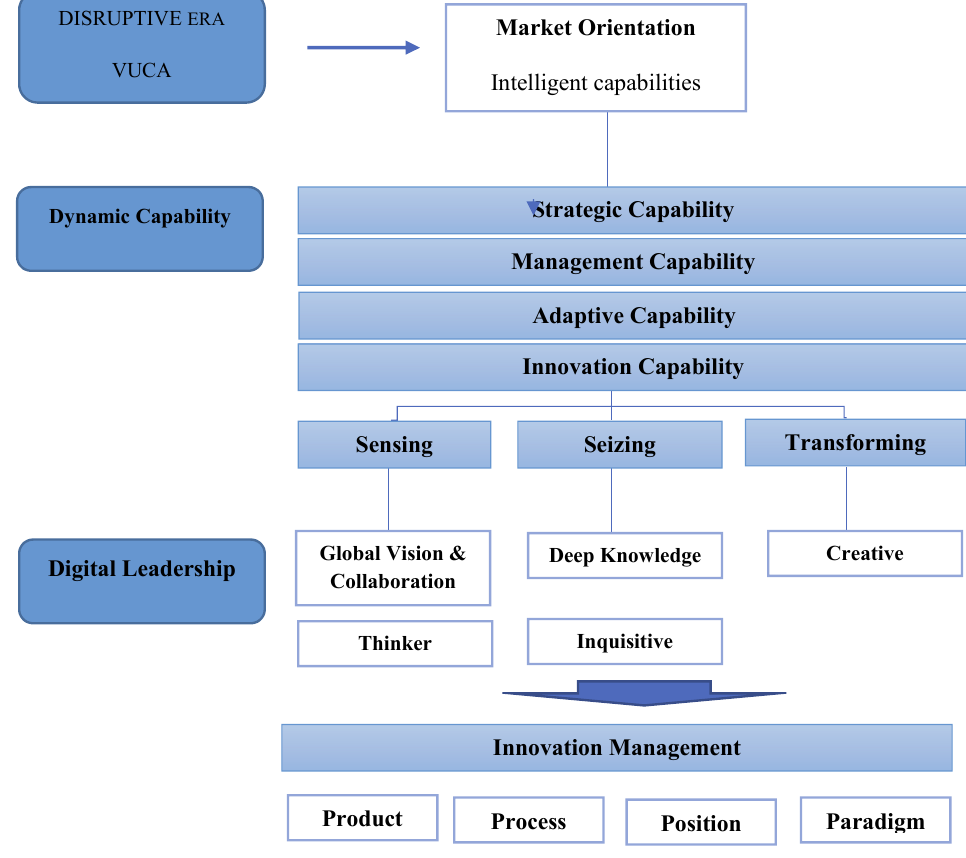
Fig. 1. Dynamic Capability based on Innovation